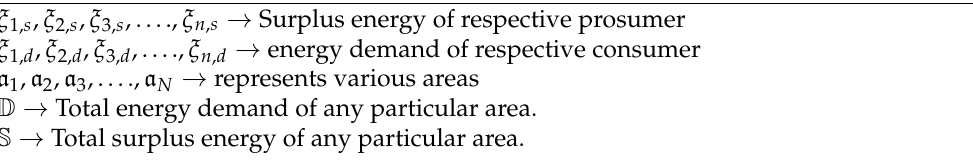
Algorithm 2 Recommender system for SPV installation.